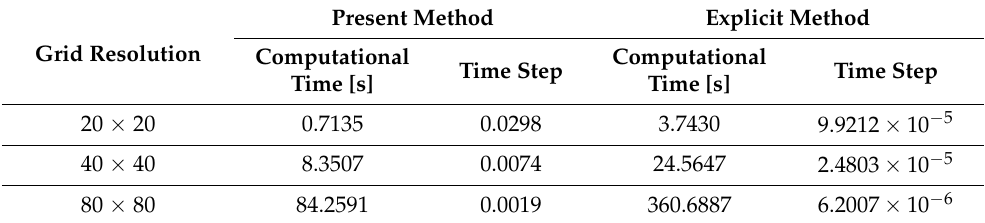
Table 2. Computational time Figure 3. Number of iterations needed for the present method to reach the convergence criterion: ( a ) 20 × 20, ( b ) 40 × 40, ( c ) 80 × 80.